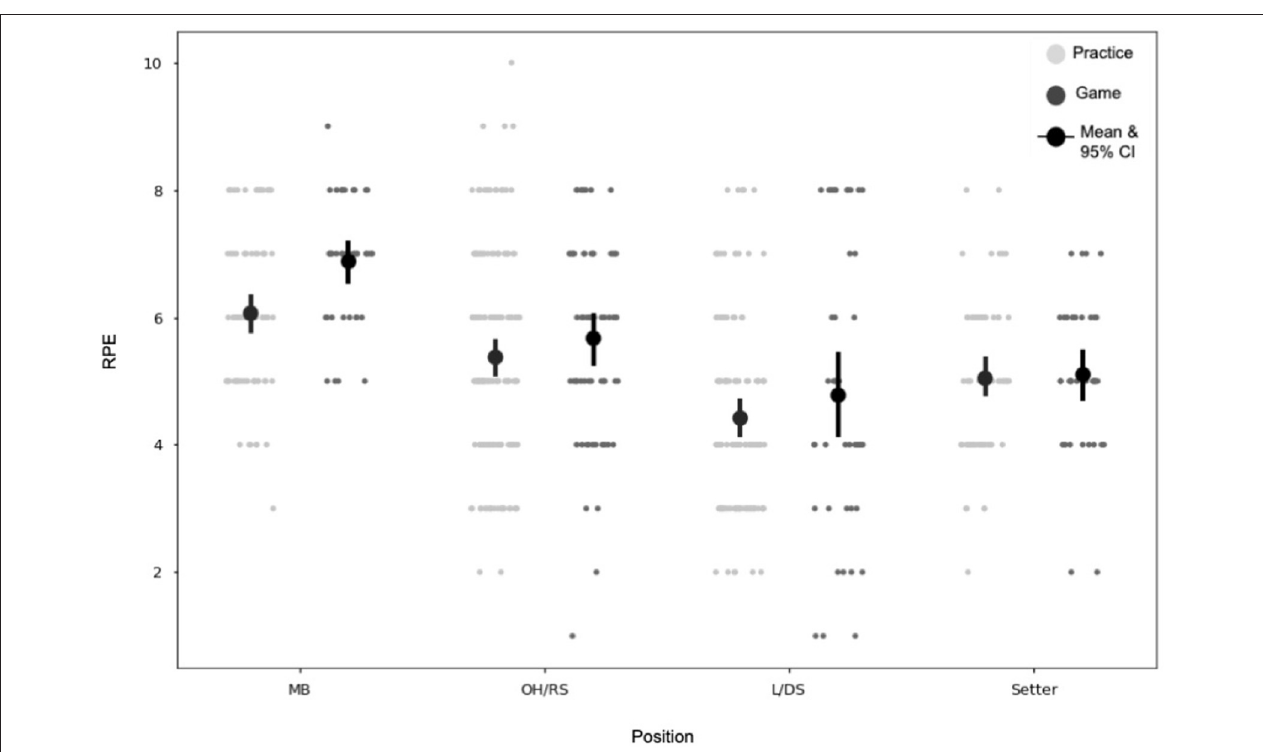
FIGURE 5 | RPE by position and session type. Each point on the graph represents an individual player-session. MB, middle blocker; OH/RS, outside hitter/right side hitter; L/DS, libero/defensive specialist; RPE, rating of perceived